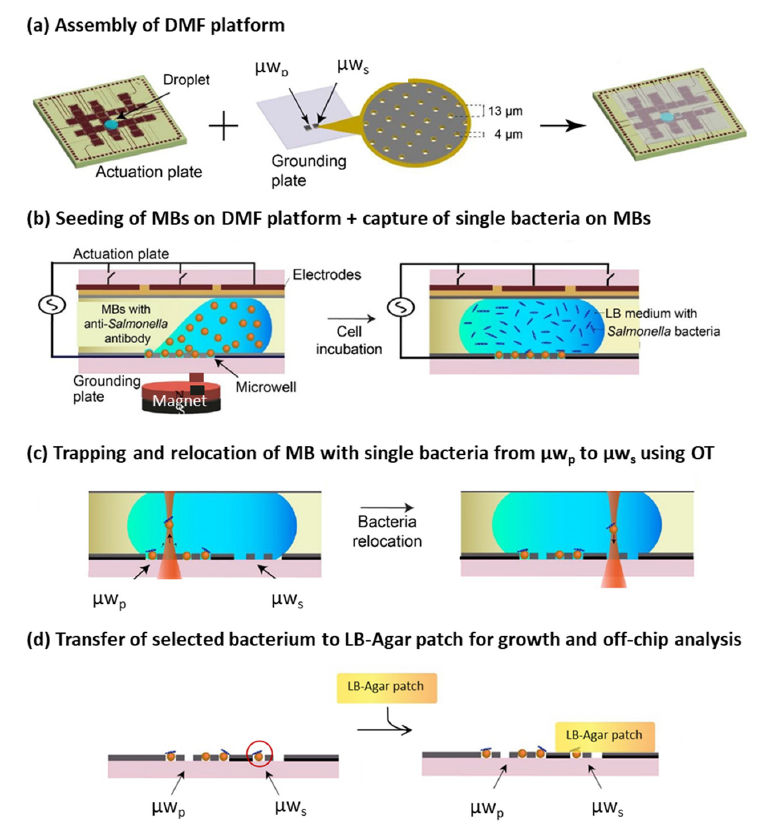
Figure 2. Schematic representation of using the OT-integrated DMF platform for capturing single bacterial cells from microwells, and their subsequent transfer for off-chip analyses. ( a ) Assembly of the DMF platform, comprising an actuation and grounding plate. The grounding plate contains the µw p array and µw s array. ( b ) Manual seeding of MBs (functionalized with anti- Salmonella antibody) in the µw p array, and capturing of Salmonella on the MBs. ( c ) OT-mediated trapping and relocation of bacteria of interest from µw p to µw s , performed after disassembly of the DMF platform by removing the actuation plate. ( d ) LB-agar patch was manually placed on the µw s to allow growth of a colony from the relocated bacterium of interest (red circle).